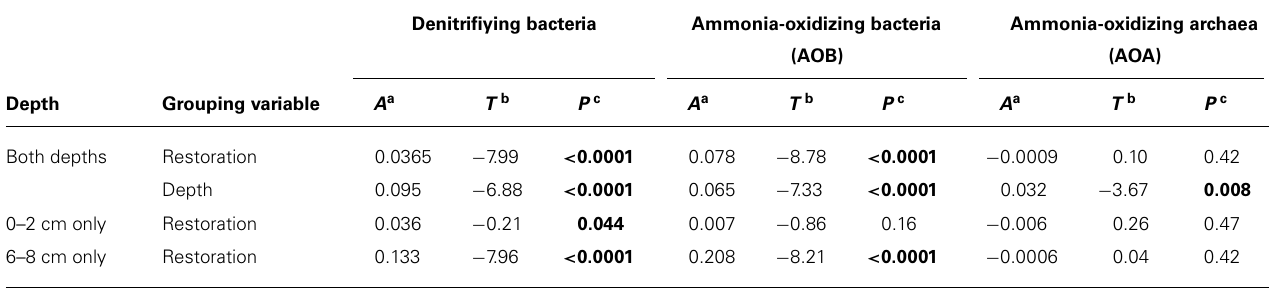
Table 2 | Results from multiresponse permutation procedure (MRPP) based onTRFLP fingerprints of nir S, betaproteobacterial amo A, and archaeal amo A